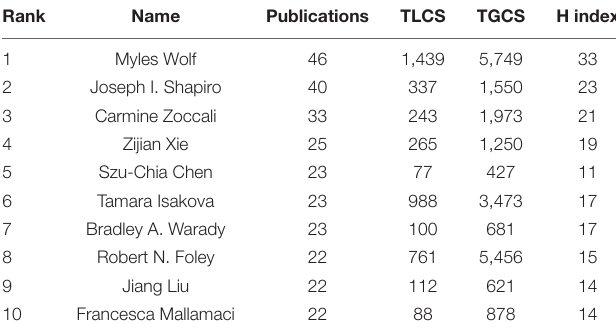
TABLE 3 | The top 10 active authors concerning uremic